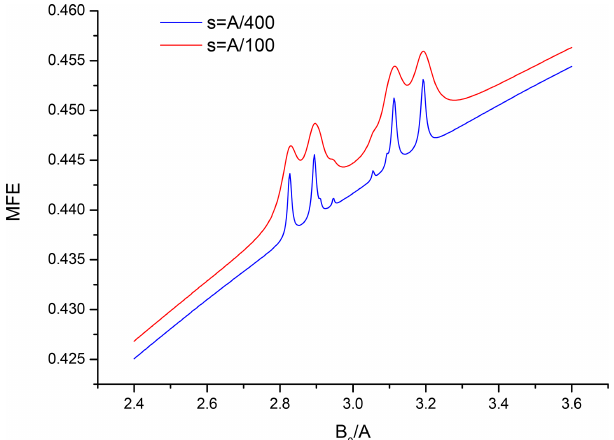
Figure 6. Region in the vicinity of B 0 = 3 A for a pair with six equivalent spin- 1 nuclei with HFC constant A in one partner and 2 two equivalent spin- 1 nuclei with a relatively large HFC constant 2 A/ 5 in the second partner, recombination parameter s = A/ 100, s = A/